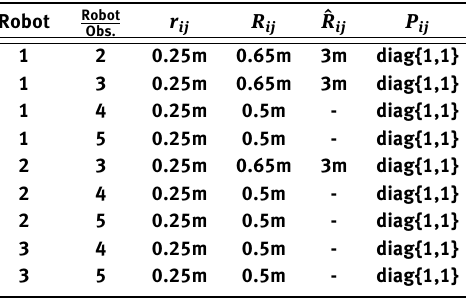
Table 6. Table of Experiment 1 pairwise parameters. Robot Robot